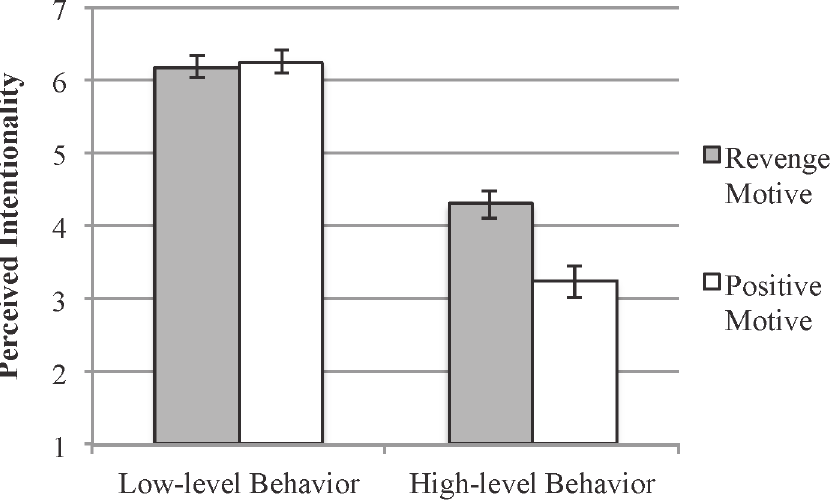
Fig 2. Intentionality judgments for low-level and high-level behavior descriptions as a function of motive information. Error bars = ± 1 SE.